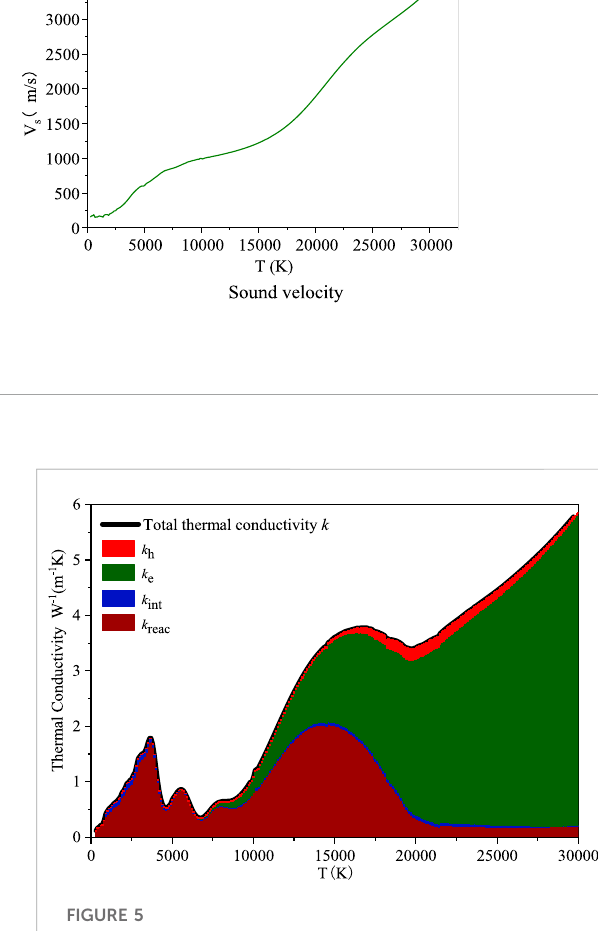
FIGURE 5 Calculation results of thermal conductivity of C 6 F 12